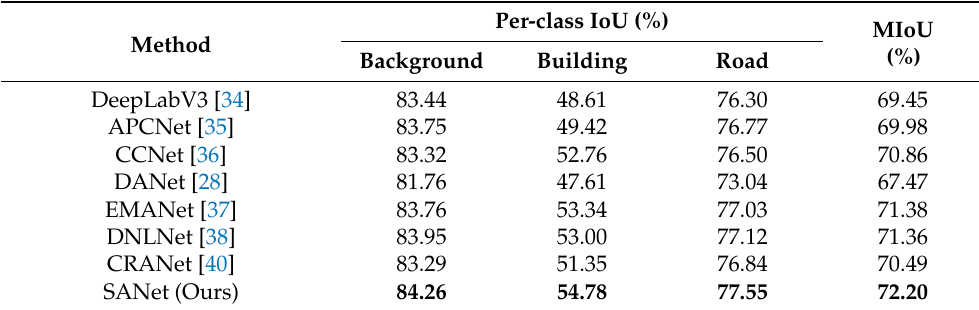
Table 7. Comparison with other methods based on the CITY-OSM dataset. Data in bold are the best